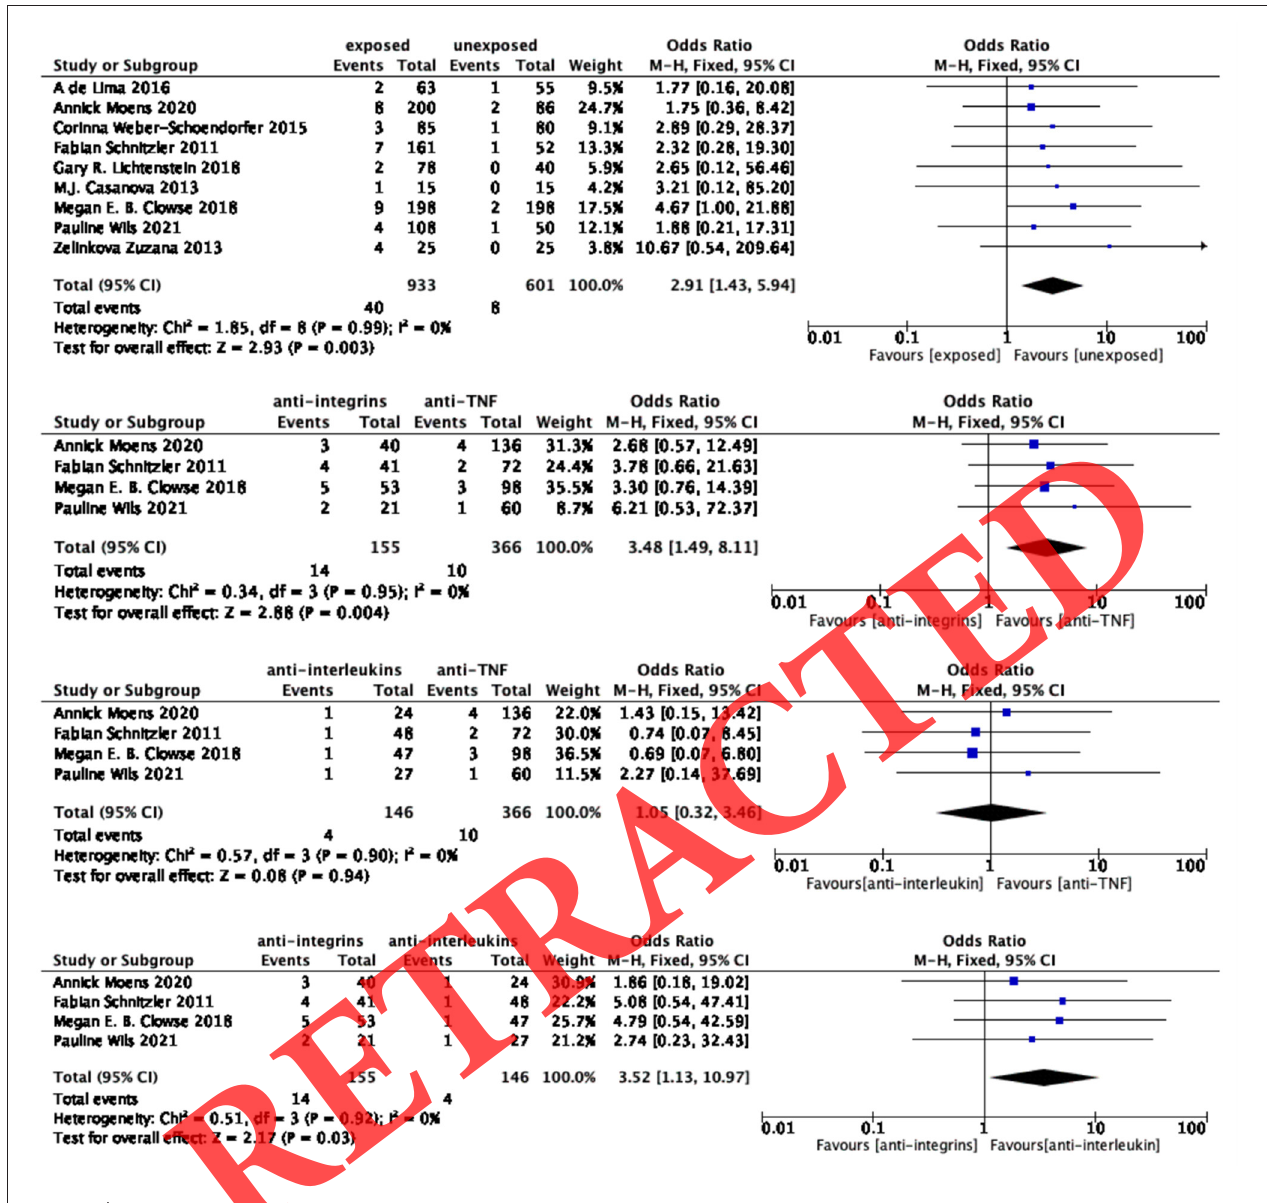
FIGURE 5 | Risk of congenital abnormality in pregnant women treated with biologics for CD.